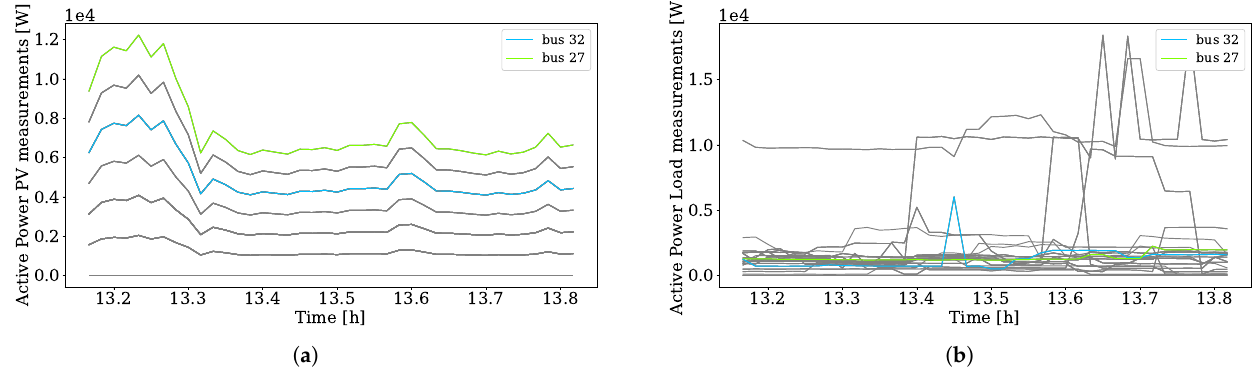
Figure 7. Results without the online control #1. ( a ) Detail of the generation profile; ( b ) detail of the load